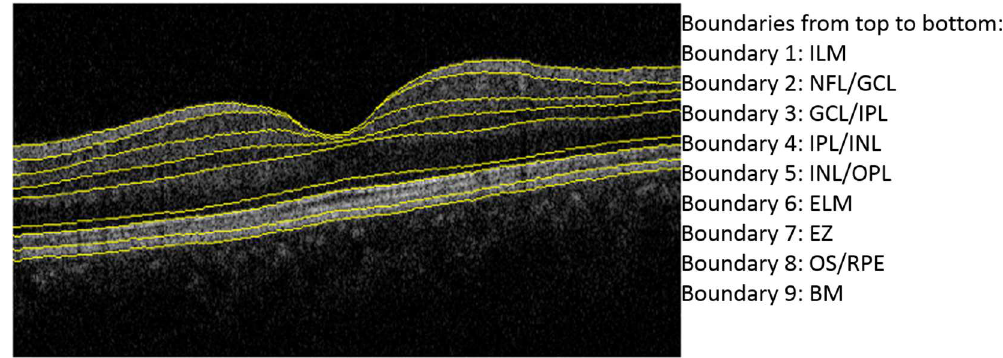
Fig 3. Automated Segmentation of Optical coherence tomography (OCT) image sets. Topcon Advanced BoundarySegmentation (TABS TM ) software was used to perform automated segmentation of nine intraretinal boundaries. in a rapid fashion. Boundary7 has previously been described as the inner aspect of the photoreceptor inner segment-outer segment junction (and is still describedas this by Topcon Inc.); however, in a recent proposed nomenclature for classification of retinal layers on OCT, this boundary is referred to as the photoreceptor ellipsoid